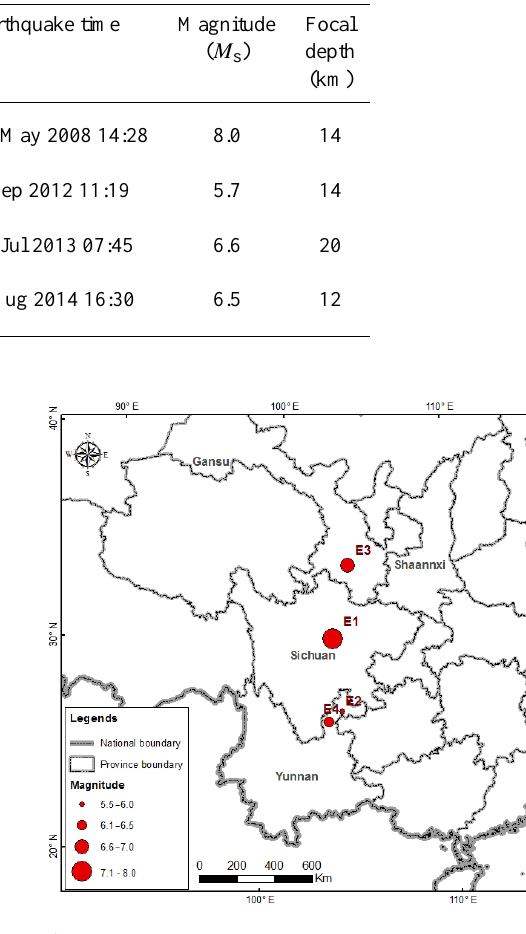
Figure 7. The locations of the four earthquakes used as test cases (see Table